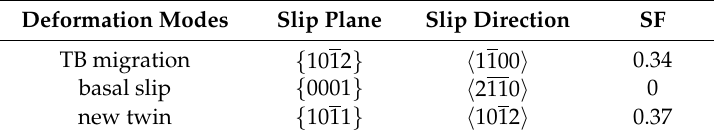
Table 2. Schmid factor (SF) of plastic deformation modes with loading axis [2 1̅1̅ 0].